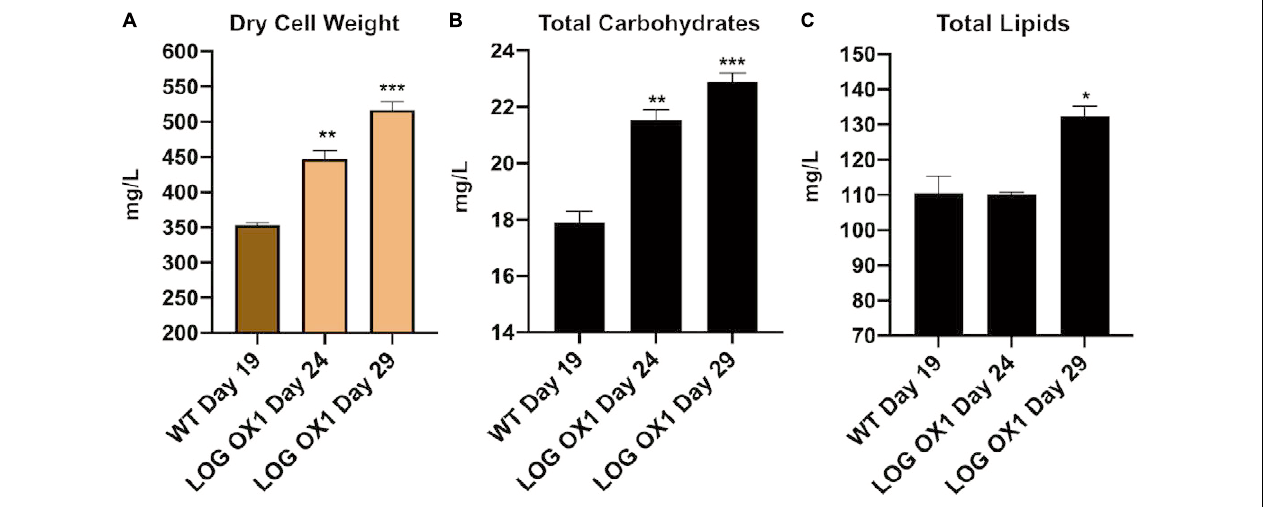
FIGURE 6 | Biomass and biochemical composition of LOG OX1 and WT cultures. (A) Biomass in terms of dry cell weight at the stationary phase of WT (19 dpi; days post inoculation) and LOG OX1 (29 dpi) cultures; bars indicate ± SE ( n = 3). (B) Total carbohydrates in terms of carbohydrate yield at the stationary phase of WT (19 dpi) and LOG OX1 (29 dpi) cultures; bars indicate ± SE ( n = 3). (C) Total lipids in terms of lipid yield at the stationary phase of WT (19 dpi) and LOG OX1 (29 dpi) cultures; bars indicate ± SE ( n = 3). For all graphs, data significant at *** P ≤ 0.001, ** P ≤ 0.01, and * P ≤ 0.05 compared with the wild type using Student’s t -test.